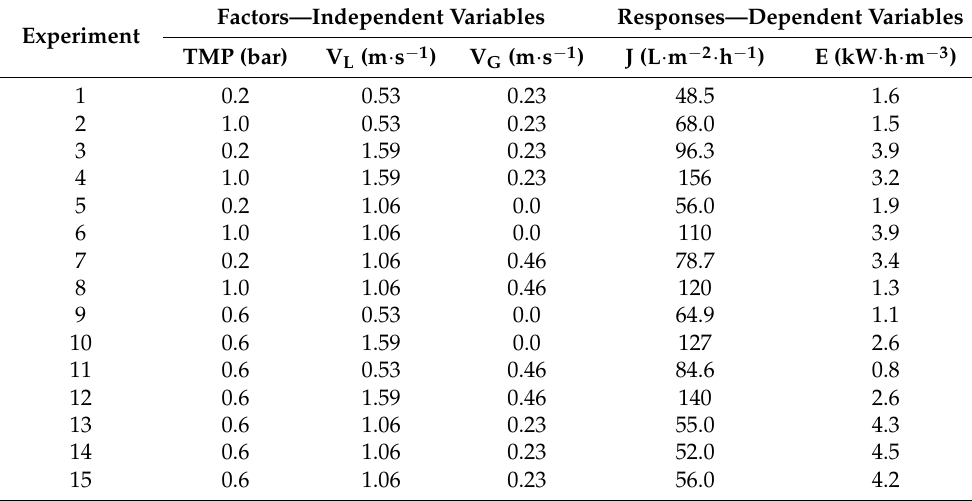
Table 1. Box–Behnken’s experimental plan for broth SMGS microfiltration